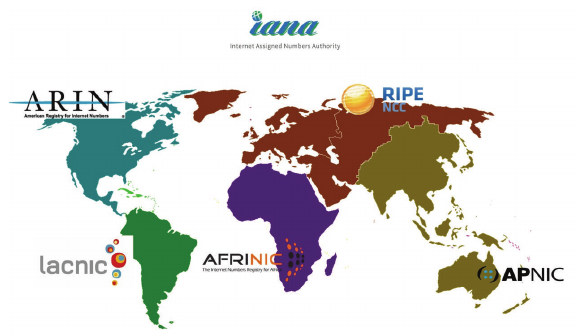
Figure 4: Global view of IP address assignment authorities.